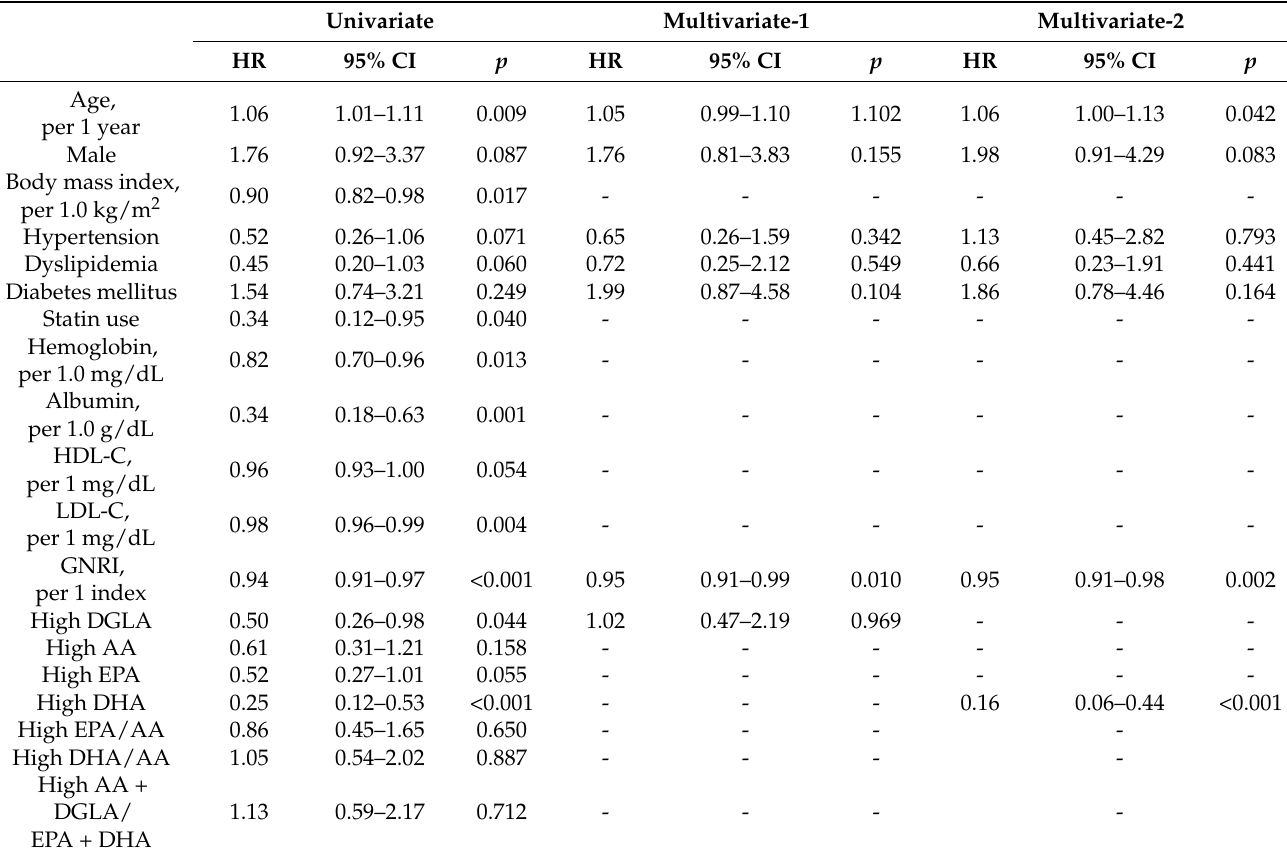
Table 2. The association between PUFAs and the primary endpoint analyzed with Cox proportional hazards